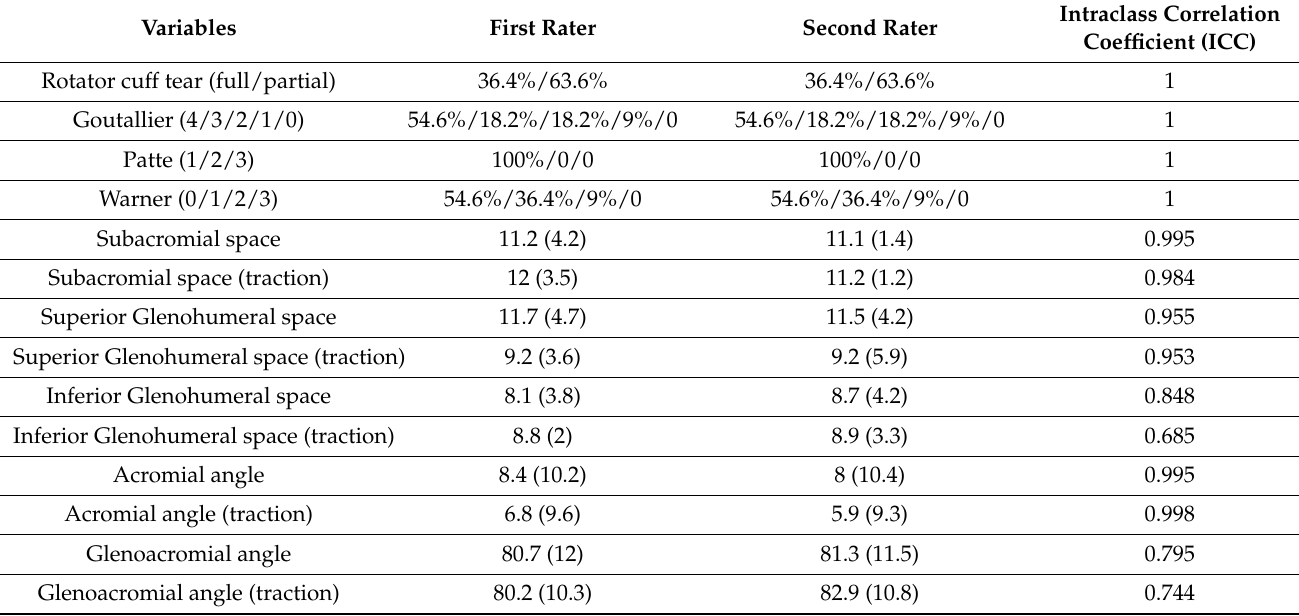
Table 3. Imaging data and intraclass correlation with and without axial traction.